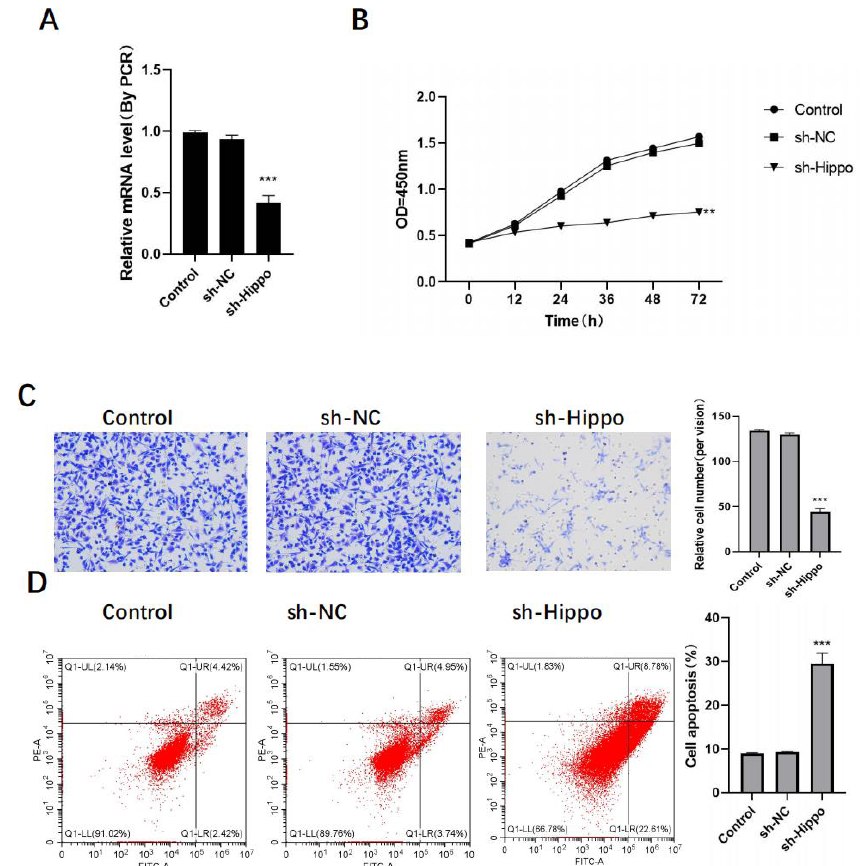
Figure 3. Knockdown of Hippo inhibits the activity of ovarian cancer cells in vitro. After Hippo transfection: ( A ) sh-Hippo transfection efficiency was detected by RT-PCR; ( B ) detection of ovarian cancer cell proliferation activity by MTT; ( C ) detection of ovarian cancer cell invasion activity by Transwell, original image × 50; ( D ) detection of ovarian cancer cell apoptosis level by flow cytometry. Compared with control group, ** p < 0.01, *** p <